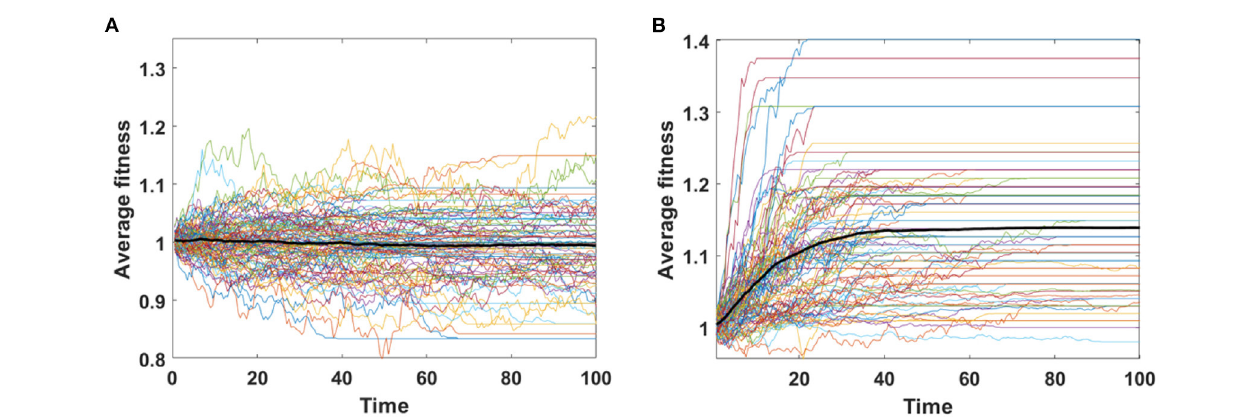
FIGURE 6 | Average fitness of cells as a function of time. Results for 100 simulations involving N = 100 cells with no mutation, but with initial number of drivers and passengers drawn from exponential distribution with parameter 10 × p for number of drivers and 10 × (1 − p ) for passengers, with p = 0.5 and rounded to the nearest integer. (A) Model A; (B) Model B. Bold lines represent means of average fitnesses from 100